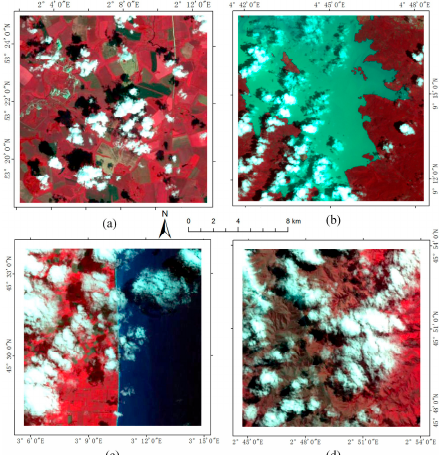
Figure 1. Cloudy images with various underlying surfaces: ( a ) green vegetation; ( b ) river; ( c ) coast; and ( d ) bare rock.